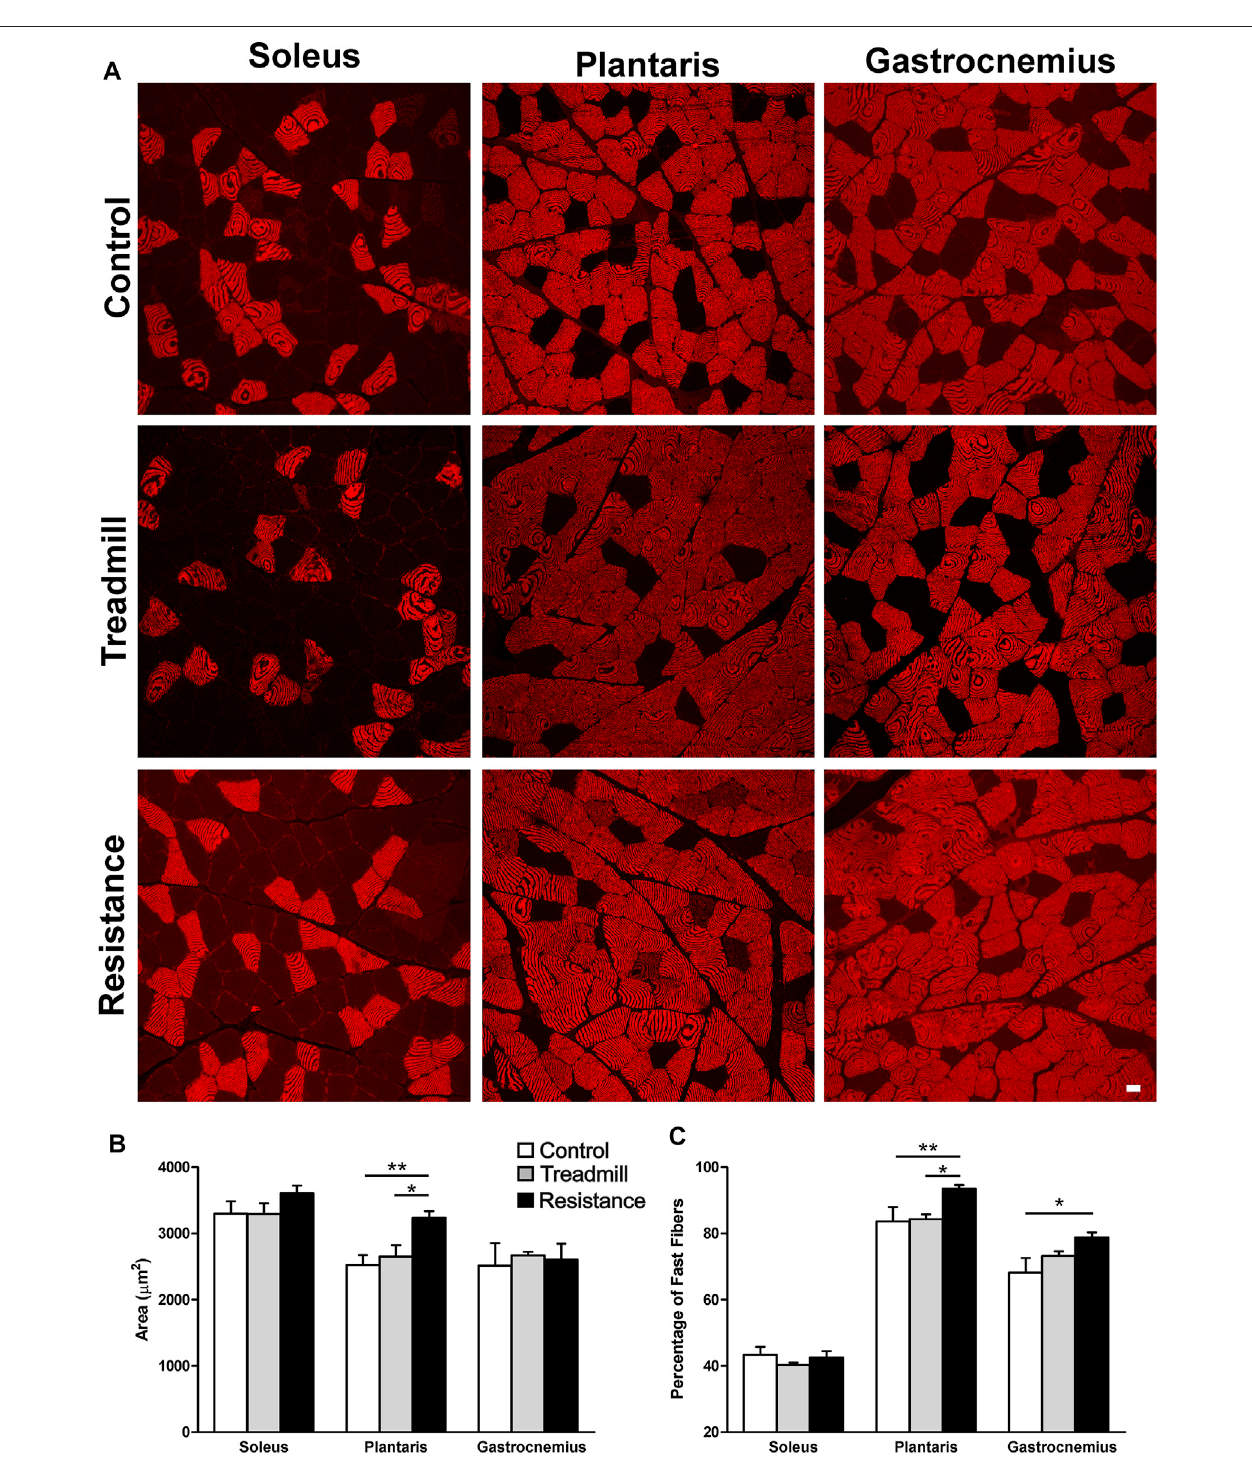
FIGURE 5 | Impact of resistance exercise on the muscle fi ber cross sectional areas (FCSA) and percentage of fast muscle fi bers. (A) Micrographs illustrate immuno fl uorescentdetectionoffastmuscle fi bersinsoleus,plantarisandgastrocnemiusmusclesofcontrolandexercisedrats. (B) Thegraphbars showFCSAanalysis of muscle fi bers in the soleus, plantaris and gastrocnemius in the control rats (open bars) or rats subjected to 11 weeks treadmill exercise (shaded bars) or 1 weeks of resistance exercise (solid bars). Resistance exercise led to a signi fi cant increase in the FCSA in the muscle fi bers of the plantaris but not in those of the gastrocnemiusorthesoleus. (C) Thegraphbarsshowthatresistanceexerciseledtoasigni fi cantincreaseinthepercentageofmuscle fi bersinboththeplantarisandthe gastrocnemius muscles. This effect was not seen in the soleus muscles. Data are presented as mean ± SEM. * p < 0.05, ** p < 0.01.